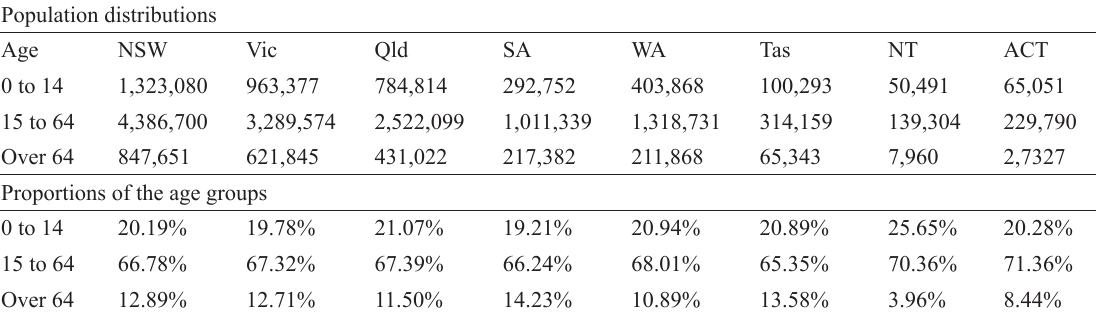
Table 1. Average annual demographic structures for Australia: 1993–2010 Population